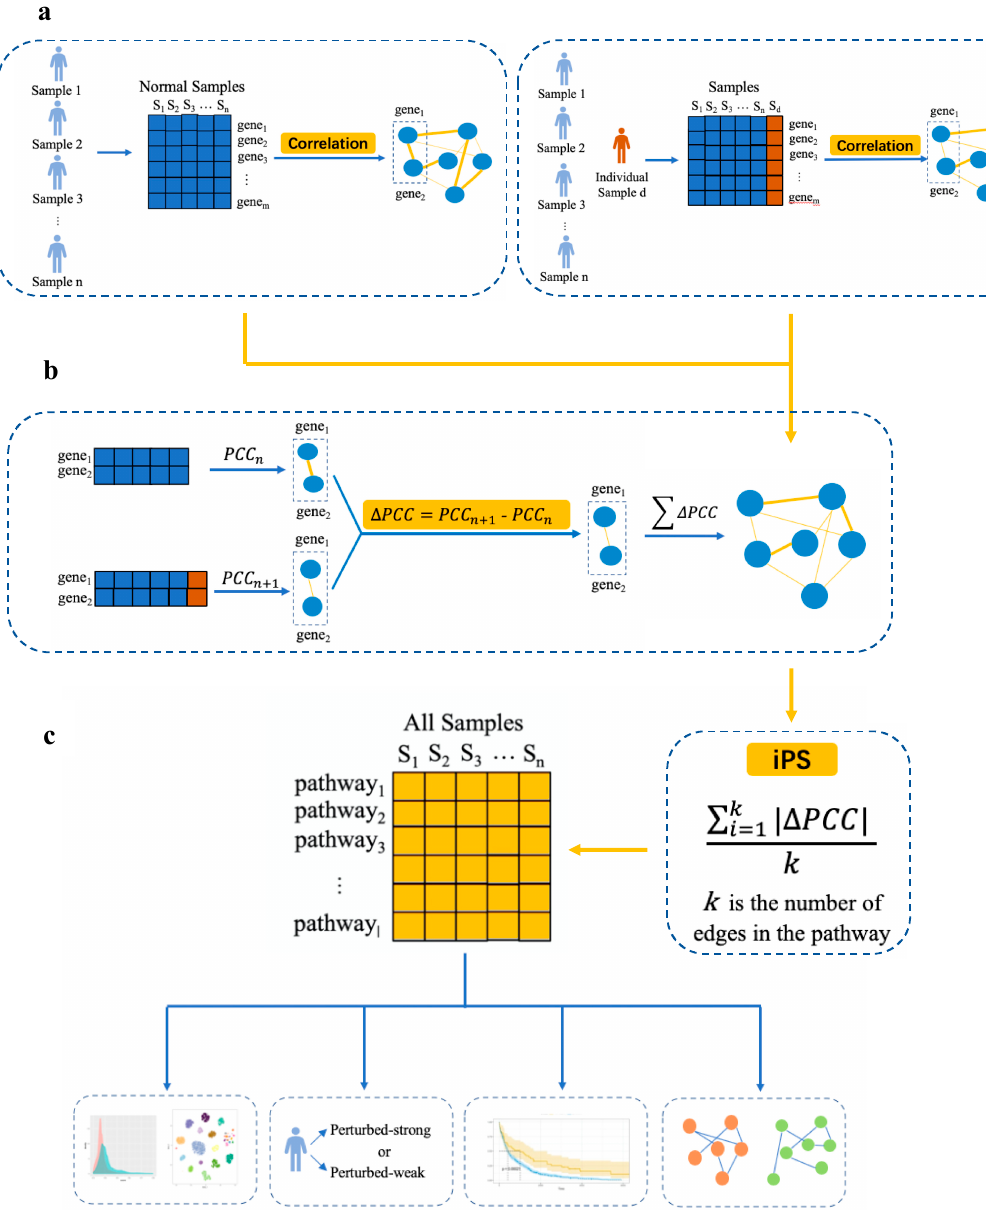
Figure 1. Flowchart of the individual-level pathway score (iPS) approach. ( a ) For a group of n normal samples, compute the correlations, i.e., the PCC n (the Pearson correlation coe ffi cient ( PCC ) of an edge in each pathway with n samples) of each edge in the pathway based on expression data. Then, a new individual sample d is added to the group, and the new correlation of each edge in the pathways is calculated in the same way by the PCC n + 1 of the combined data. ( b ) The pathway-based di ff erential correlation is calculated by the di ff erence of the corresponding edge in terms of PCC , i.e., ∆ PCC = PCC n + 1 − PCC n for each edge. The sum of all edges, the ∆ PCC value, is obtained for each pathway. ( c ) iPS is defined as an individual pathway-based score that can quantify the correlation perturbation of each pathway in each sample. Finally, analyses of distribution, classification, survival, and prognosis are